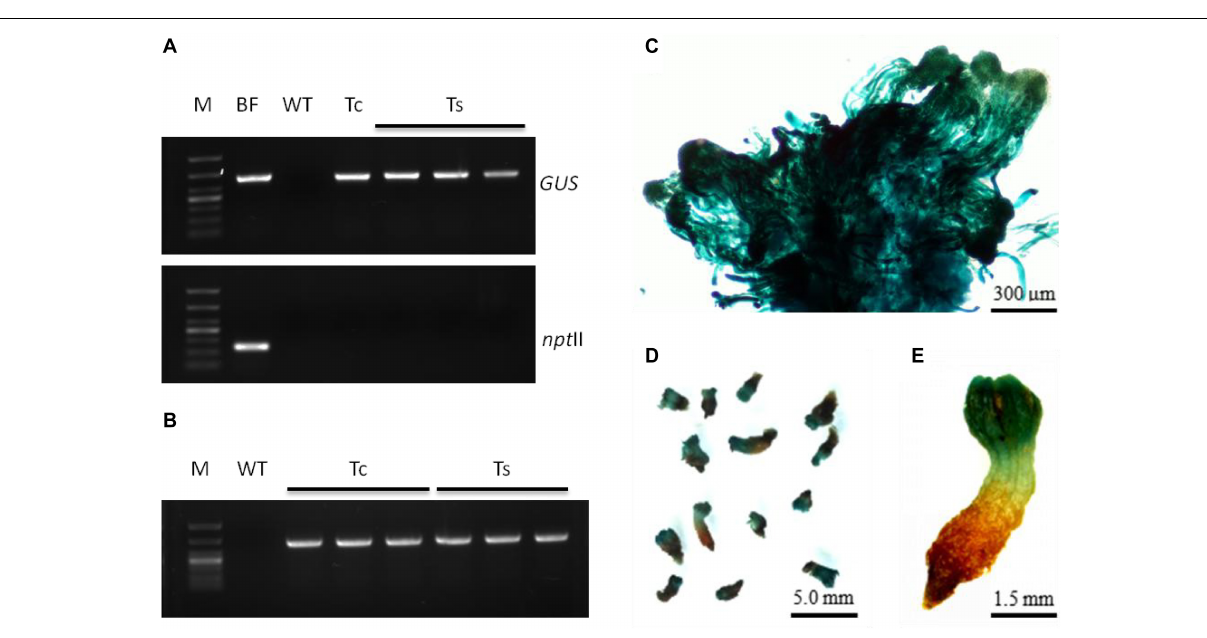
FIGURE 7 | Molecular detection and expression analysis of transgenic embryogenic cultures of L. olgensis with GUS gene. (A) PCR amplification of GUS and npt II genes in Agrobacterium GV3101 containing p1300- Pt HCA 2-1pro-GUS, untransformed wild-type (WT), and transgenic callus (Tc) or somatic embryos (Ts). Lane M is 1 kb ladder. (B) RT-PCR amplification of GUS gene in WT and transgenic embryogenic cultures (Tc or Ts). Pt HCA 2-1pro-GUS transformed callus (C) or somatic embryos (D,E) after staining with